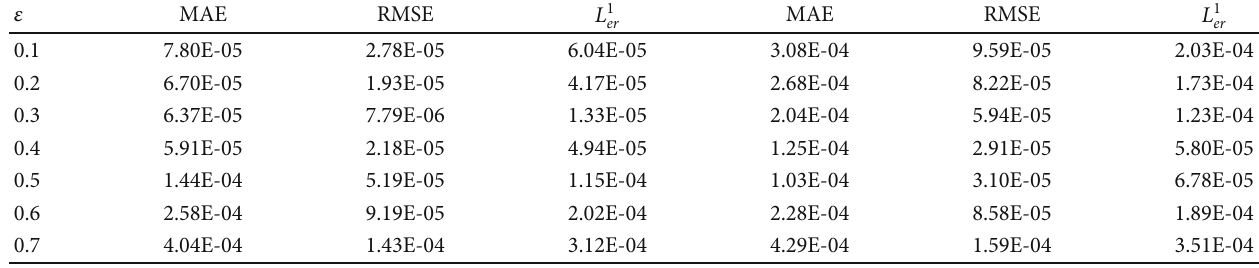
Table 3: Results for di ff erent values of ε in Example 1 with N conditions.